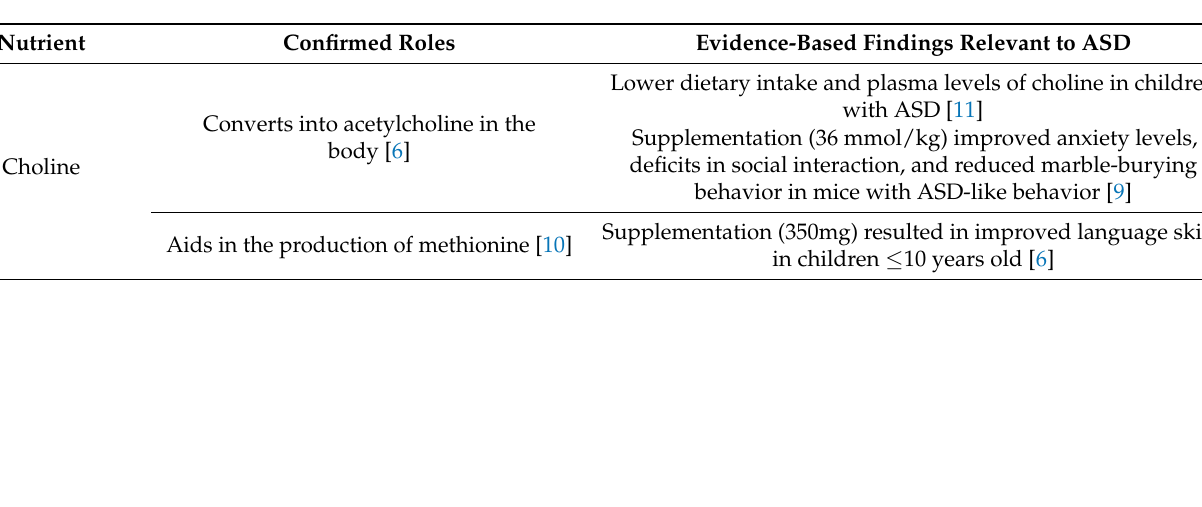
Table 2. Nutrient